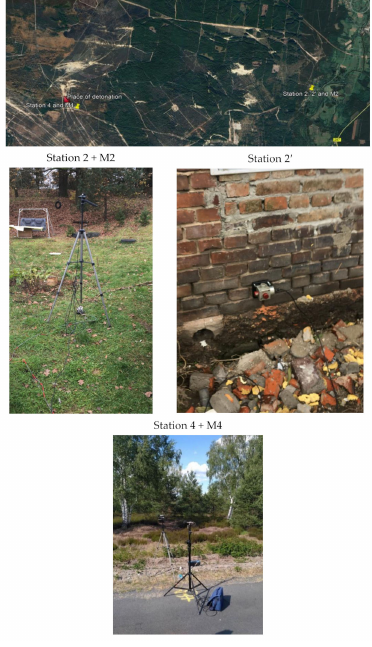
Figure 10. Blasting site and measurement stations.